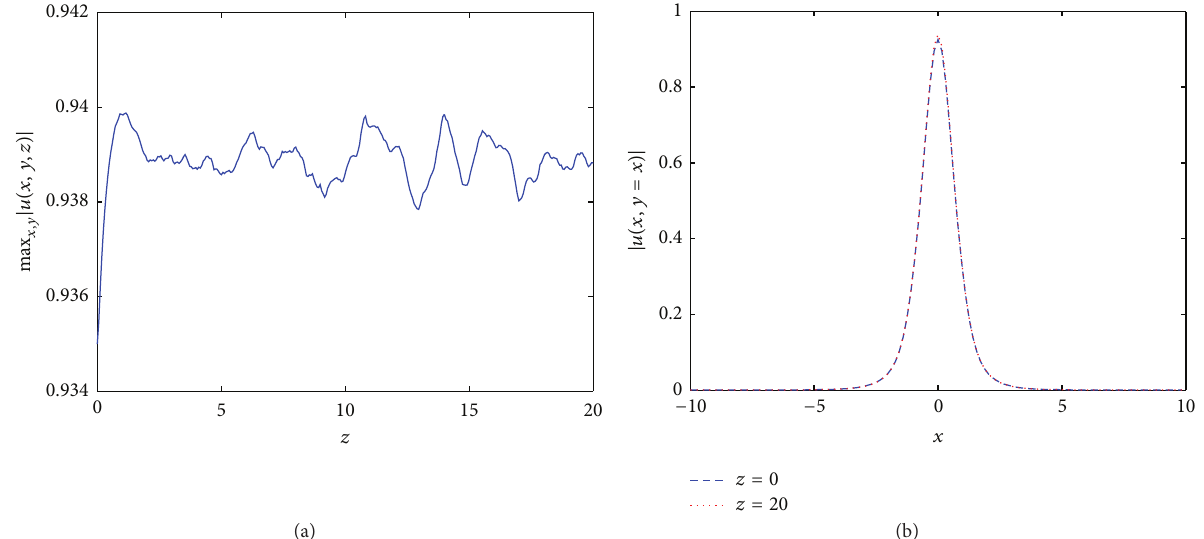
Figure 22: Nonlinear evolution of the lattice soliton situated at the Penrose potential with 𝜇 = 1.5 for the self-focusing quintic model. (a) Peak amplitude of the lattice soliton as a function of the propagation distance. The initial condition is taken as the lattice soliton with a 0.01 noise in the amplitude and phase; (b) cross section along the diagonal axis of the lattice soliton before and after evolutions ( 𝑧 = 0 and 𝑧 = 20